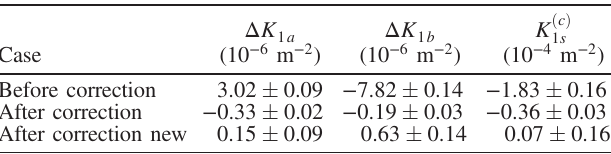
TABLE III. Estimates of corrector strengths before and after having modified the strengths of Q2L (magnet a ), Q2R (magnet b ), and the skew quadrupole correctors of IR1. The last row (After correction new) is obtained after subtracting from the second row (After correction) the difference between the cor- rector strengths estimated prior to correction and the corrector strengths actually used in the